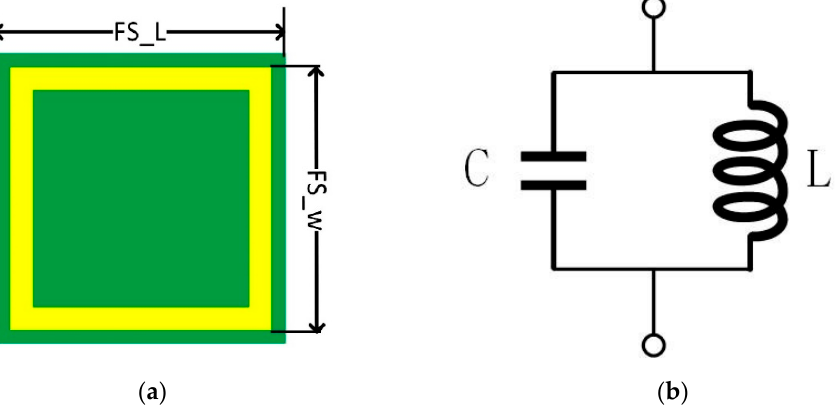
Figure 4. ( a ) An FSS element and ( b ) its equivalent schematic.